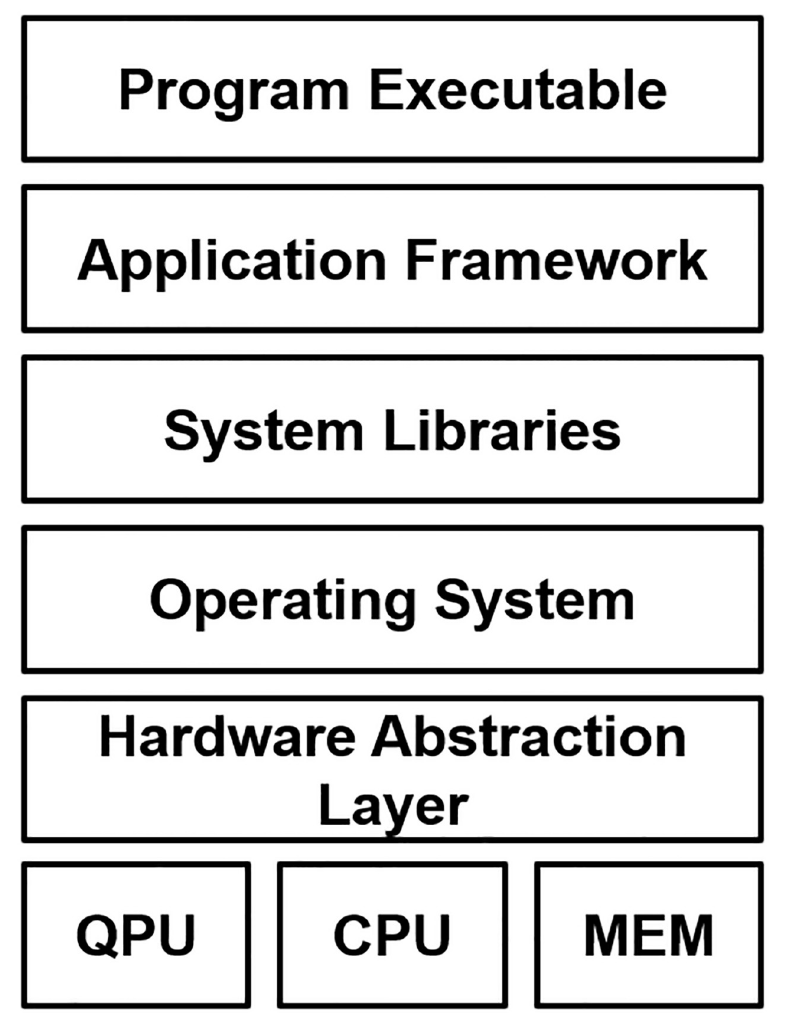
Fig 6. A schematic design how a quantum virtual machine (QVM) manages access to an underlying QPU through the hardware abstraction layer. A program binary exists within an application framework that accesses system resources through libraries. Library calls are managed by the host operating system, which manages and schedules requests to access hardware devices including attached QPUs. The hardware abstraction layer (HAL) provides a portable interface by which these requests are made to the underlying QPU